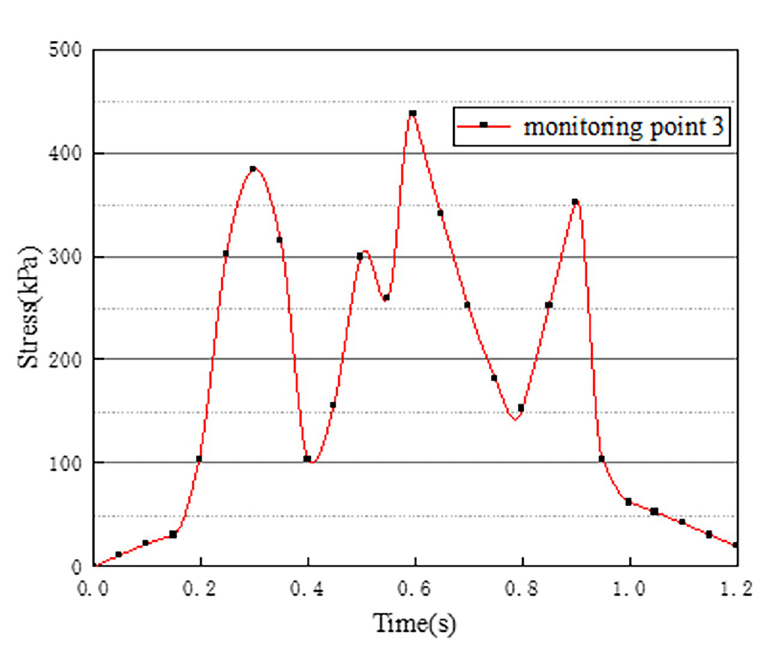
Fig 9. Stress time history curve of monitoring point 3.